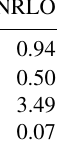
Table 6. Comparison between observations (AERONET) and model (CHIMERE) for the daily mean aerosol optical depth (AOD). Results are presented for the spatial correlation R s between the mean observed and modelled values and the mean averaged values of temporal correlation, RMSE and bias.